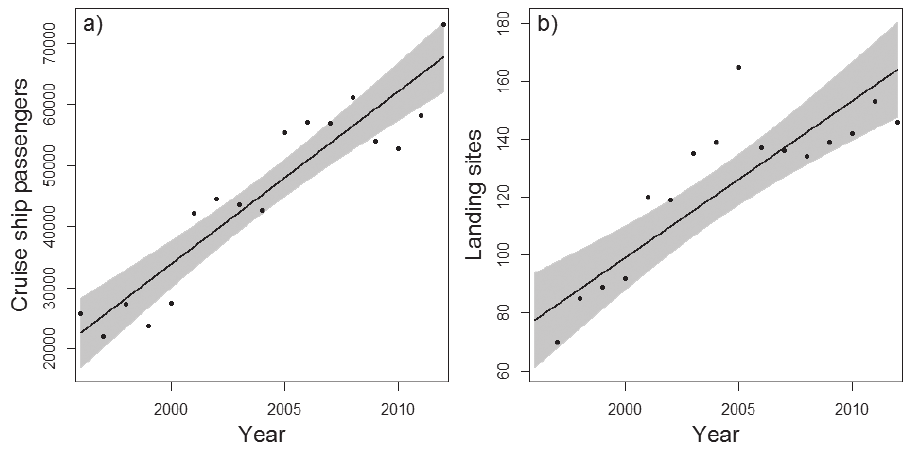
Figure 2. Temporal trend of cruise ship tourism on Svalbard: a) number of cruise ship passengers visit- ing Svalbard per year and b) number of different landing sites visited by cruise ships on Svalbard per year. Linear regressions and 95% confidence intervals are depicted as lines and shaded areas,